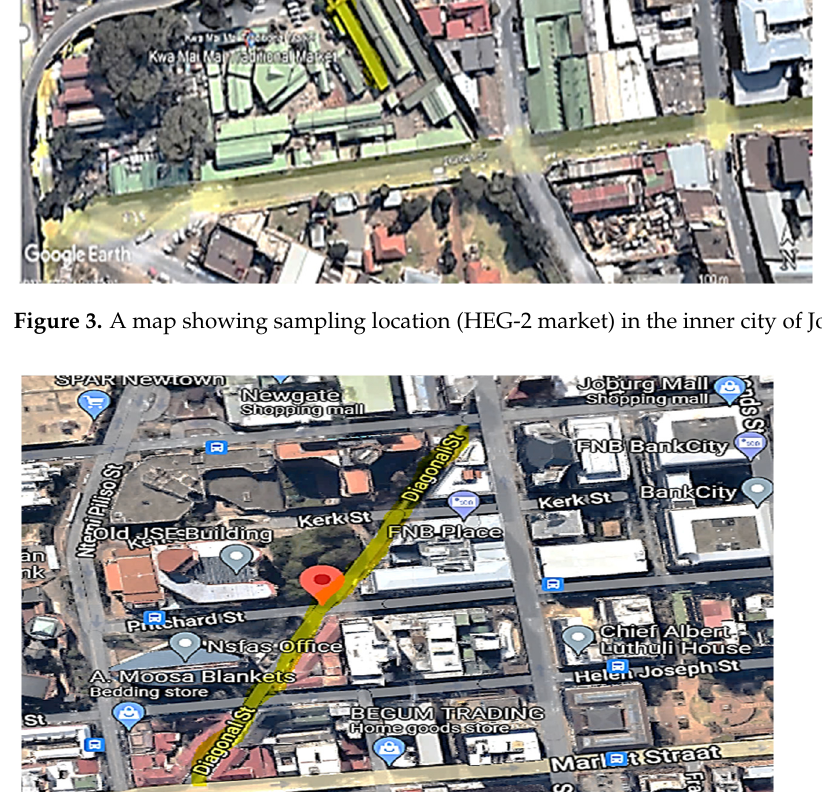
Figure 3. A map showing sampling location (HEG-2 market) in the inner city of Johannesburg [18].